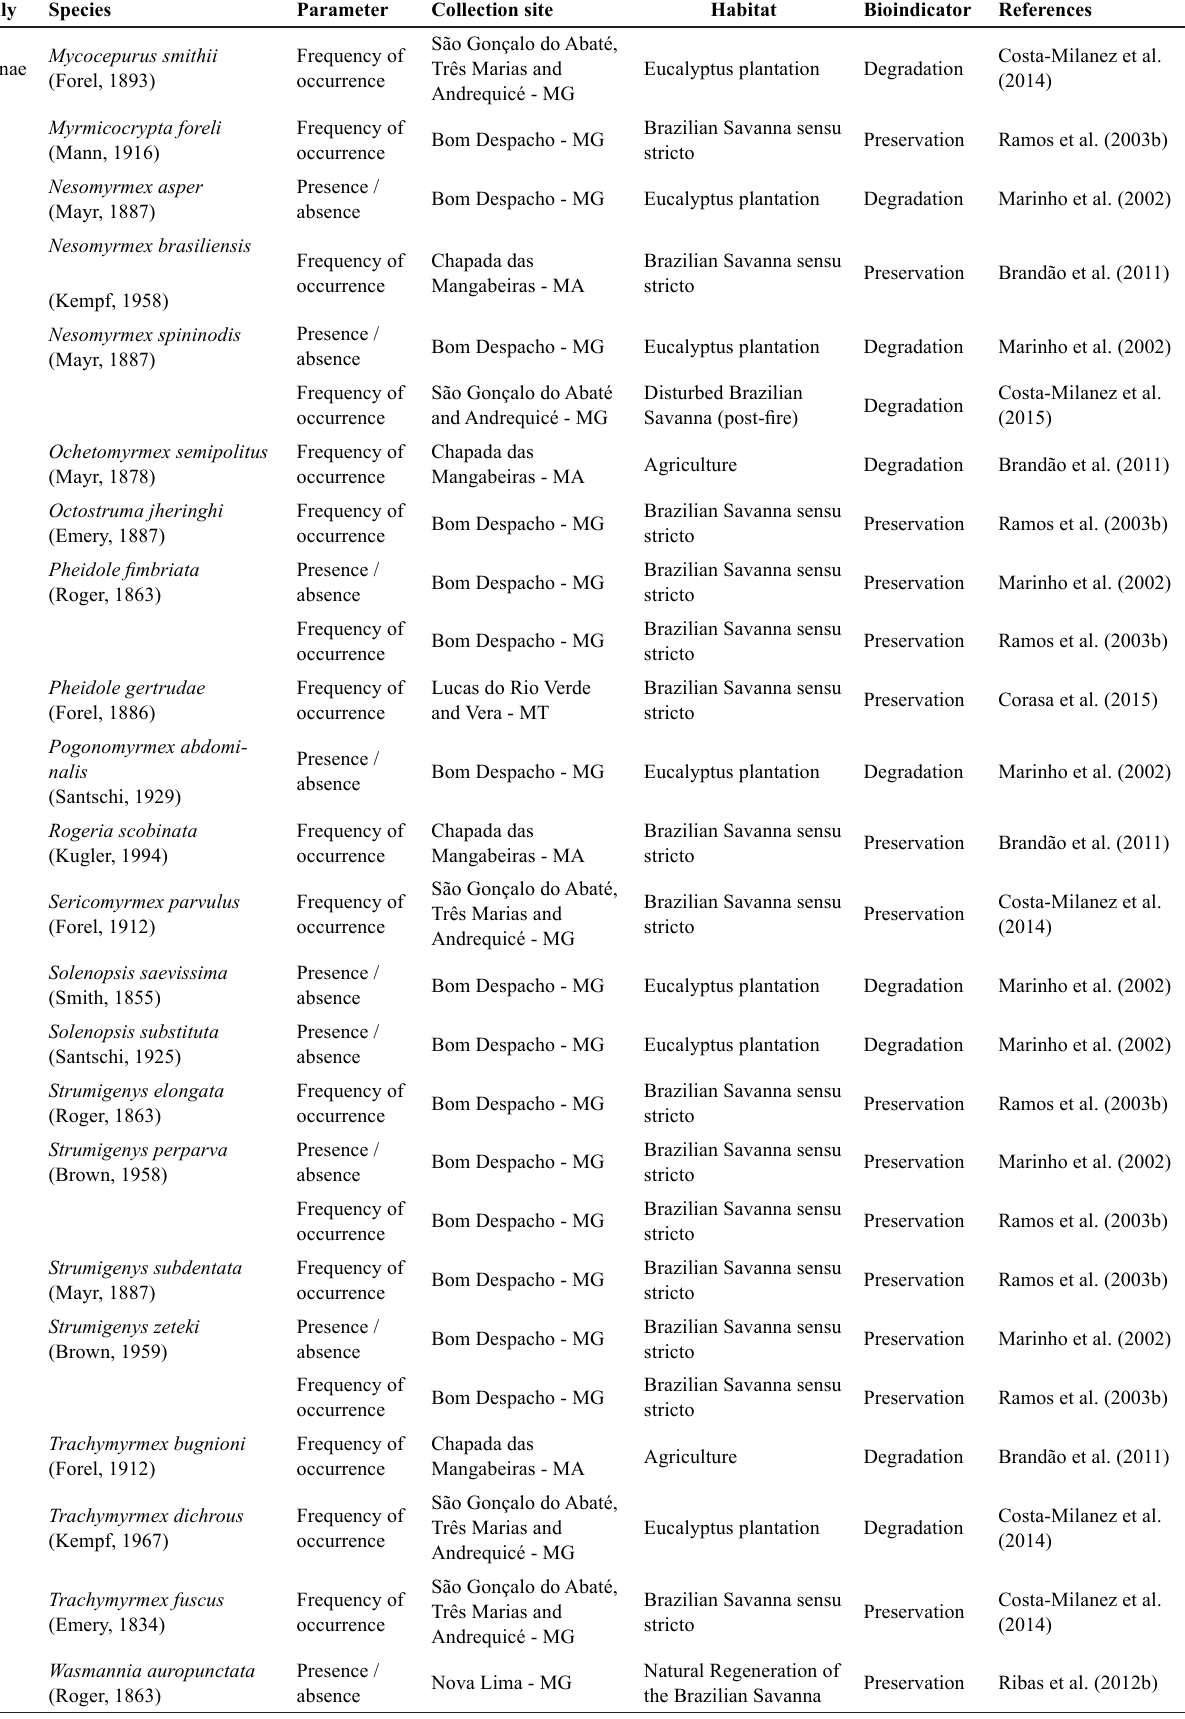
Table 3. Species of ants defined as bioindicators for preservation or degradation in the reference studys, indicating the parameter used to relate to the habitat type, and the reference of the papers analyzed. (Continuation)